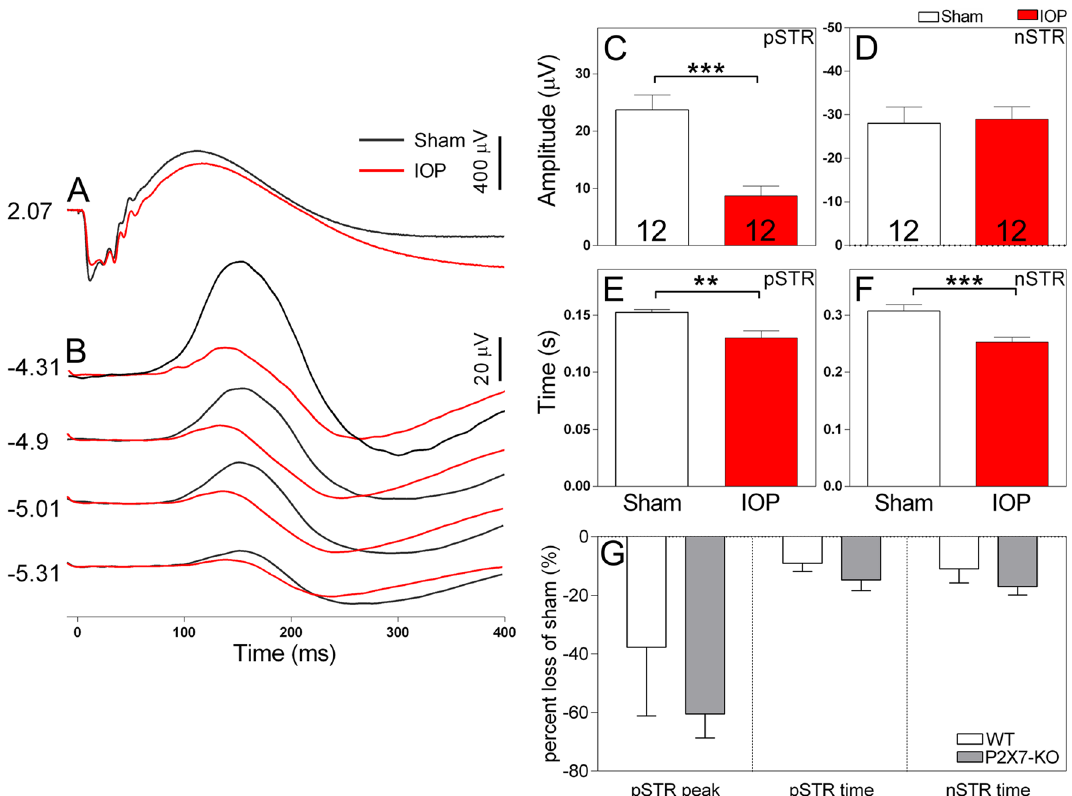
Figure 4. Electroretinogram recordings of P2X7-KO mice show a predominant reduction in the pSTR amplitude, without sign of rescue following acute IOP elevation. Representative waveforms of retinal responses measured at bright (( A ), 2.07 log cd·s/m 2 ) and dim (( B ), − 5.31 to − 4.31 log cd·s/m 2 ) luminous energies. Average amplitude of the pSTR ( C ) and nSTR ( D ) following sham (white bars) or elevated IOP (red bars) treatment. Average implicit time to the peak amplitude of the pSTR ( E ) or nSTR ( F ) following sham or elevated IOP treatment. The amplitude and implicit time of the pSTR was significantly reduced in eyes subject to elevated IOP. ( G ) The effect of IOP on pSTR and nSTR responses expressed as a percentage loss of the sham eye show no differences between P2X7-KO and WT. Numbers indicate the number of mice. ** p < 0.01, *** p < 0.001; paired t-test (sham vs